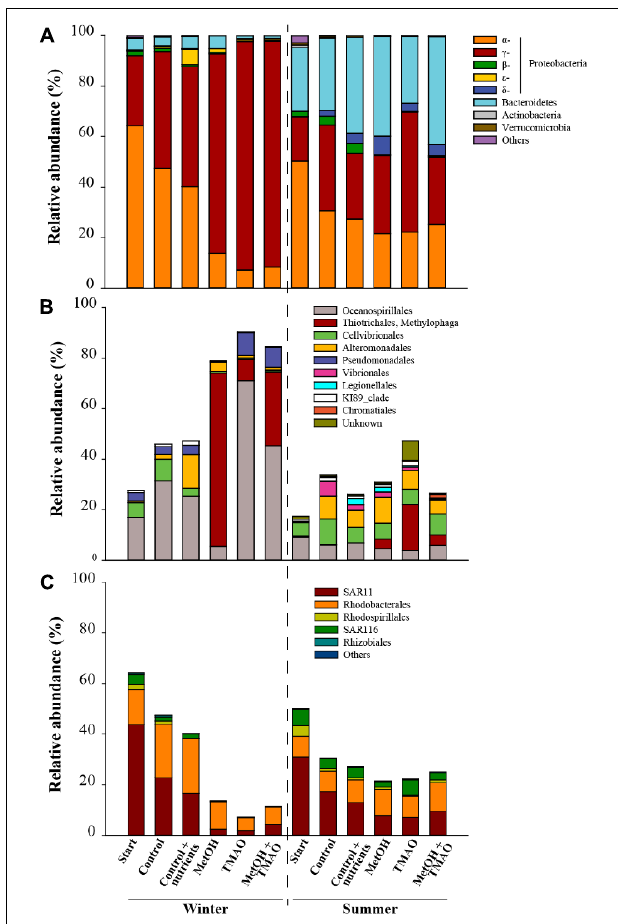
FIGURE 4 | Relative abundance of the main bacterial phyla and subclasses (A) , γ -Proteobacteria (B) and α -Proteobacteria (C) in winter and summer experiments. Relative abundances are expressed as % of total 16S rRNA gene sequences in the original assemblage or as a mean of the treatment triplicates at the end of the